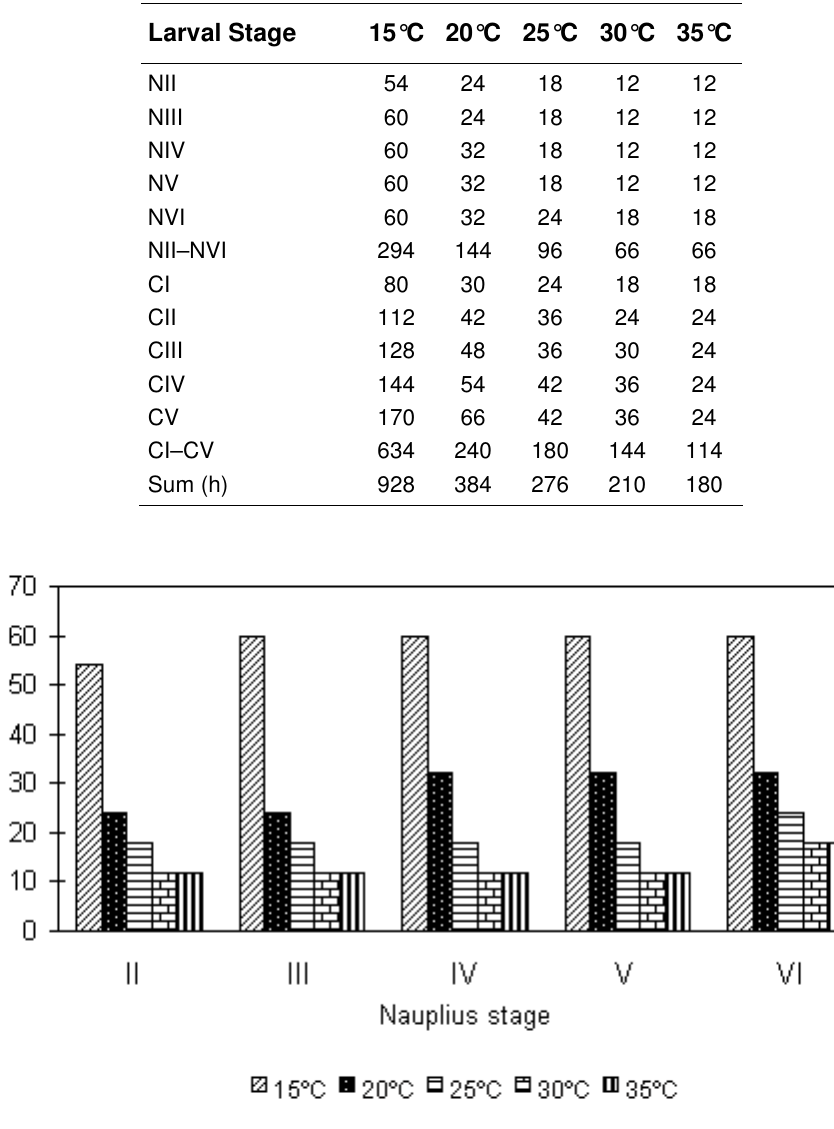
FIGURE 1 . The development time of nauplii of P. dubia under different